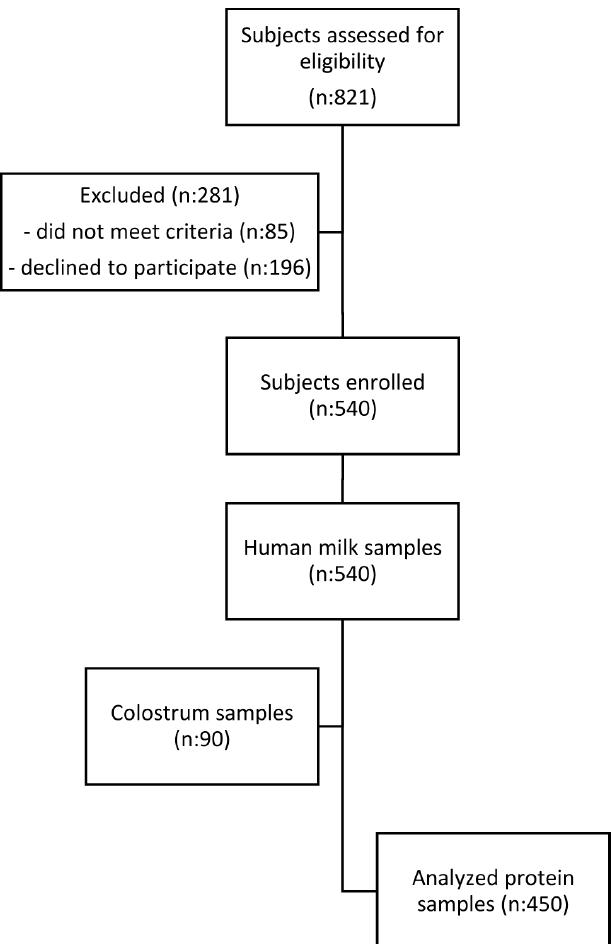
Figure 1. Study flow chart of subject recruitment.